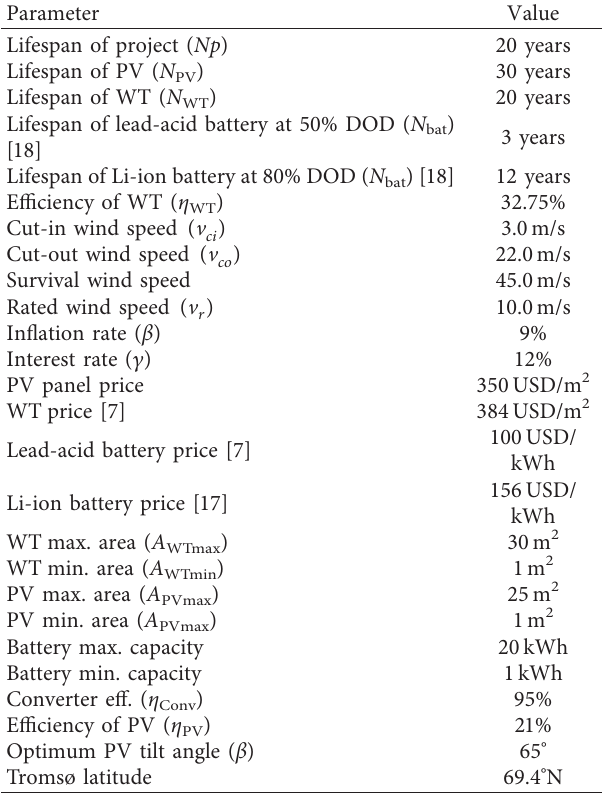
Table 1: Data used in the simulation